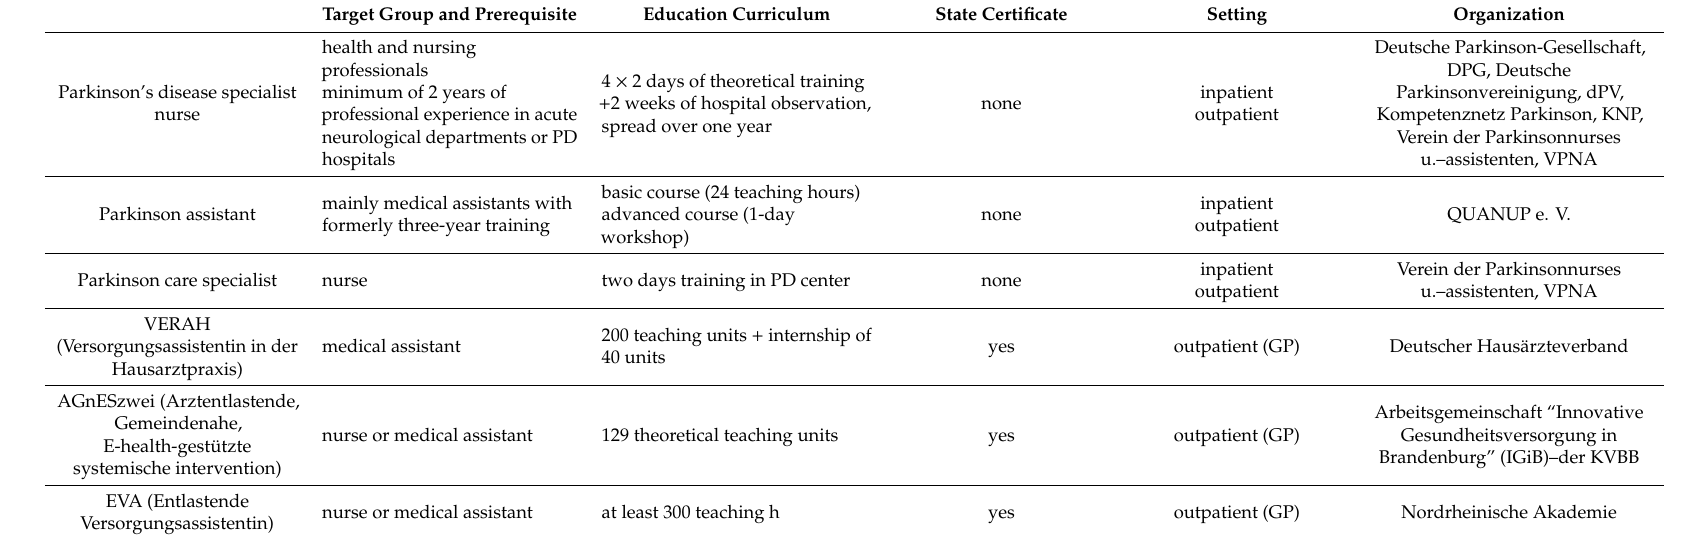
Table 1. An overview of the existing forms and regional models of Parkinson´s disease (PD)-specific nonphysician sta ff